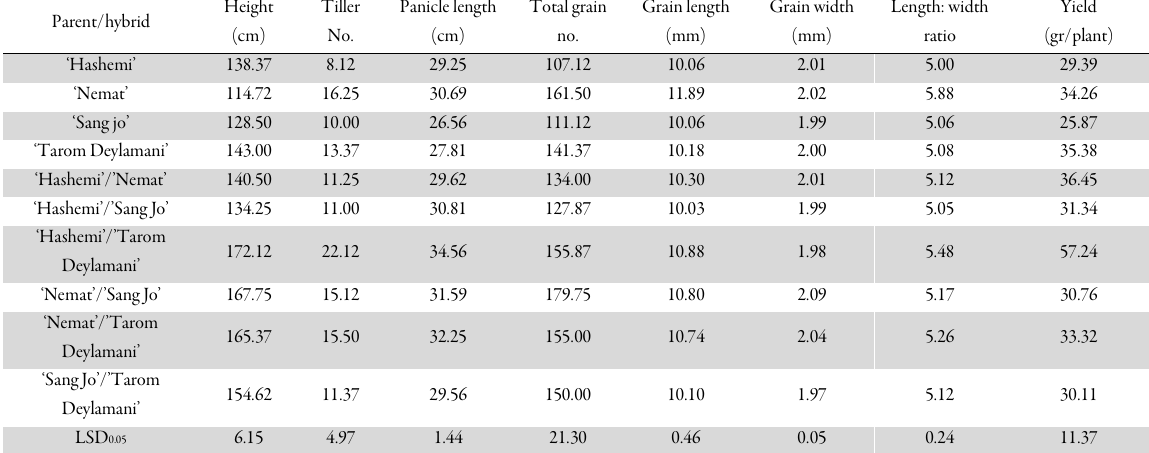
Table 1. Mean performance of parents and hybrids for studied traits Parent/hybrid